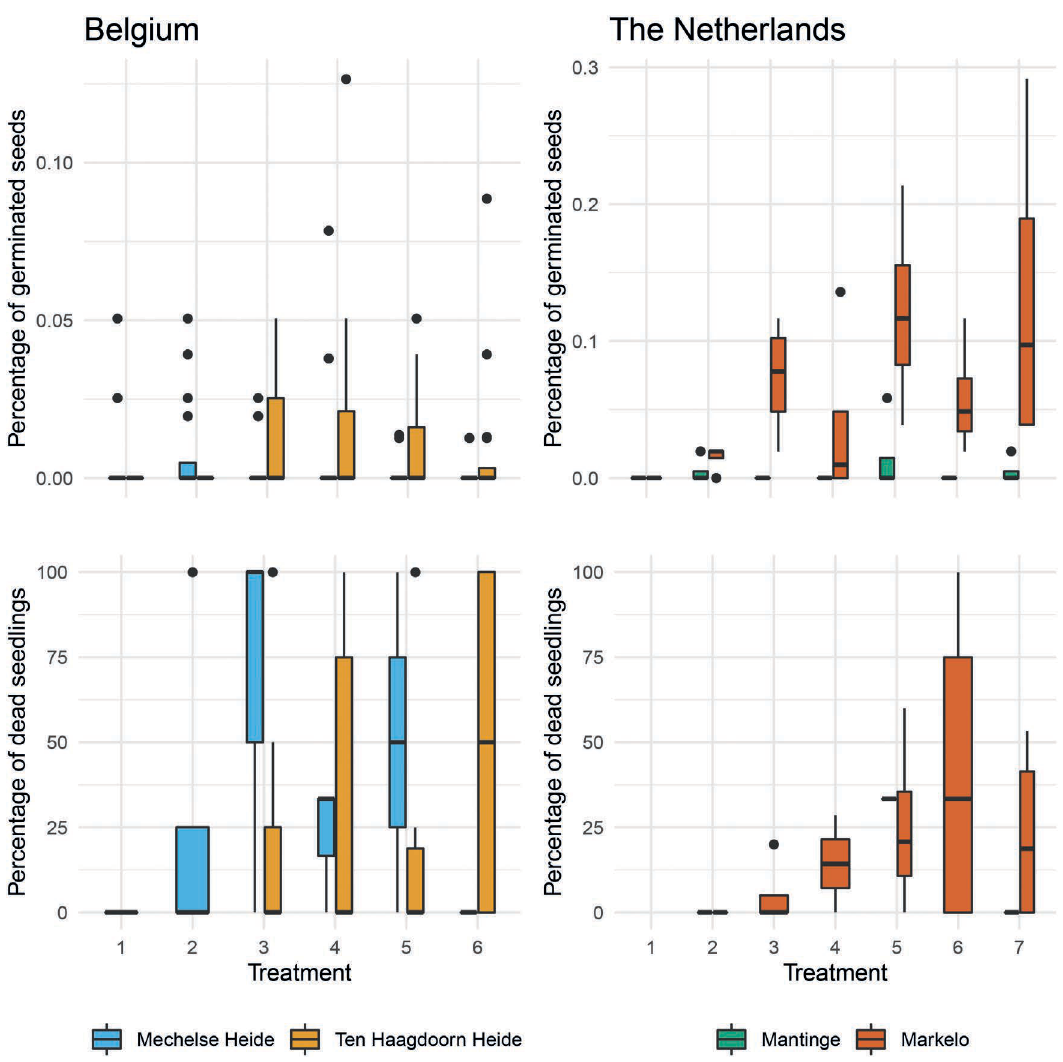
Figure 2 – The response of common juniper seed germination and seedling survival to the experimental treatments. The percentage of germinated seeds and dead seedlings and the different soil variables are displayed per treatment and per site as violin and box plots. The proportion of germinated seeds (and dead seedlings) was calculated by dividing the number of germinated seeds by the total number of germinated plus non-germinated seeds (and dead seedlings divided by the total number of living and dead seedlings, respectively). Treatment numbers are described in the caption of figure 1. The total number of plots was n = 104; n = 48 in Belgium (24 per location) and n = 56 in the Netherlands (28 per